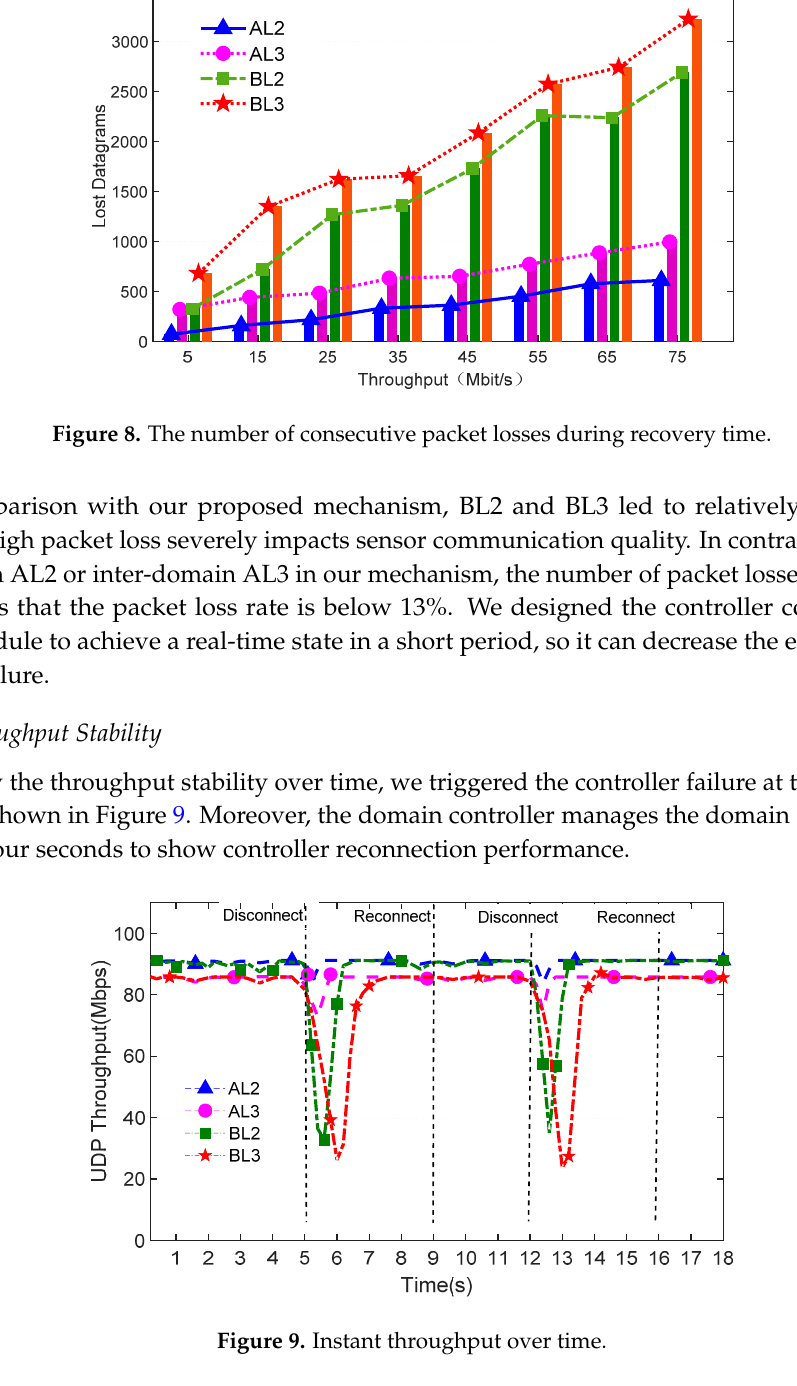
Figure 9. Instant throughput over time.